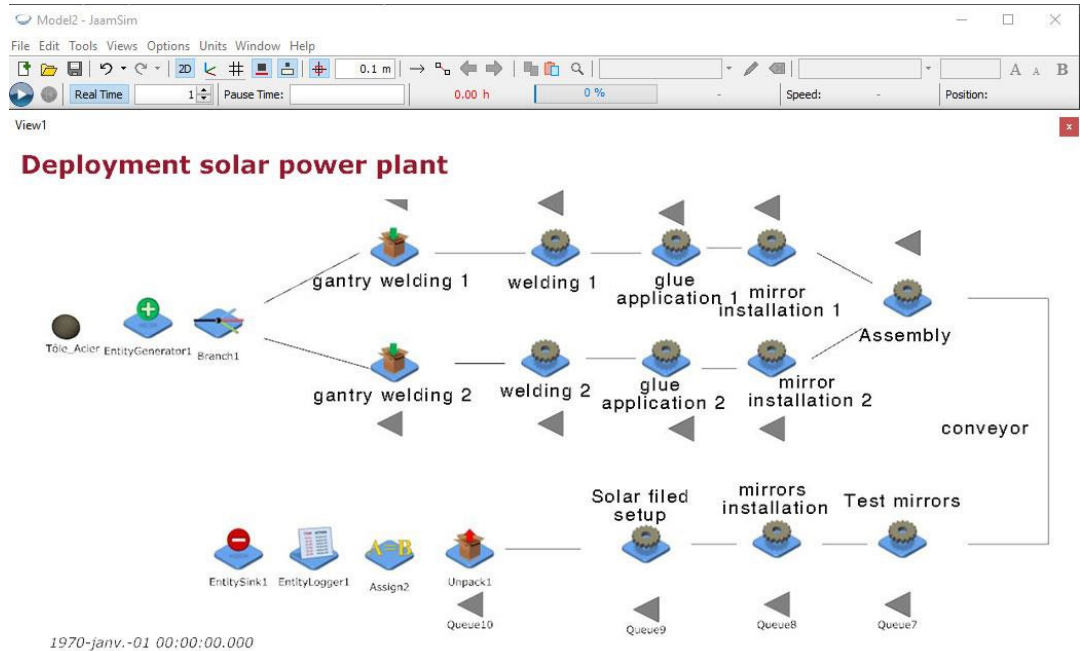
Figure 14. JaamSim deployment of the power plant.